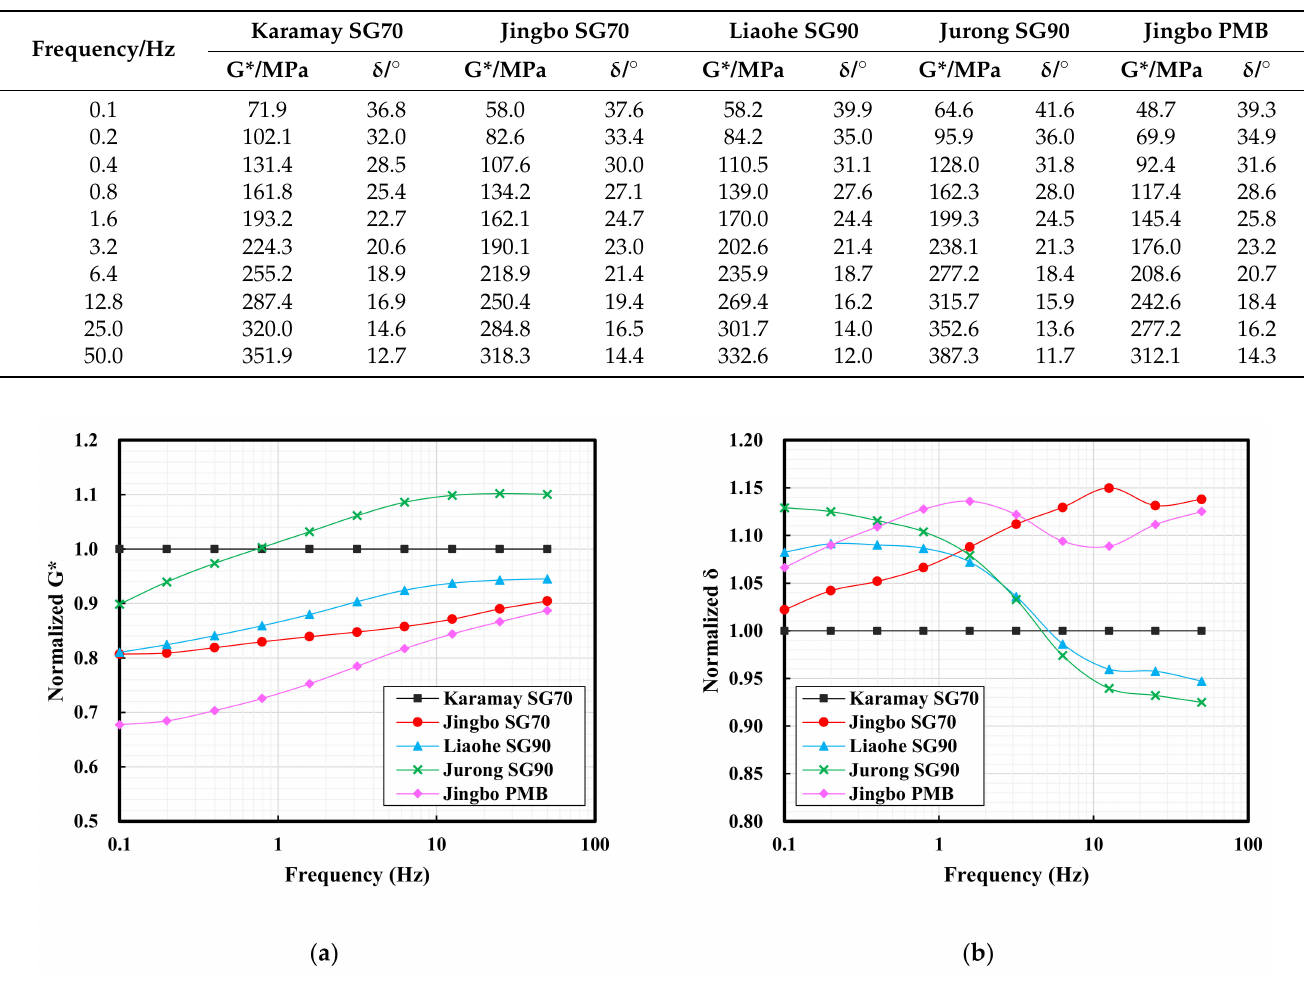
Table 5. The complex modulus (G*) and phase angle ( δ ) of five hydraulic bitumen binders at − 10 ◦ C.